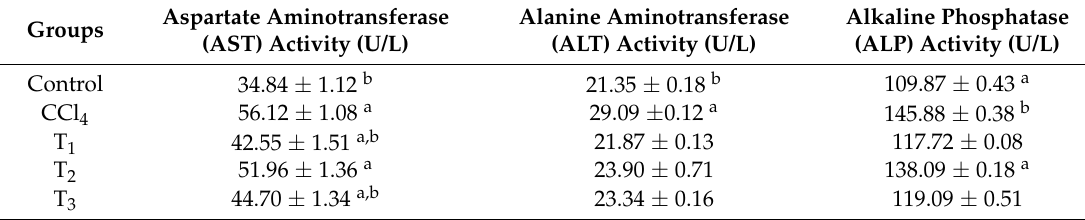
Table 2. The effect of Piper guineense on indices of hepatotoxicity.